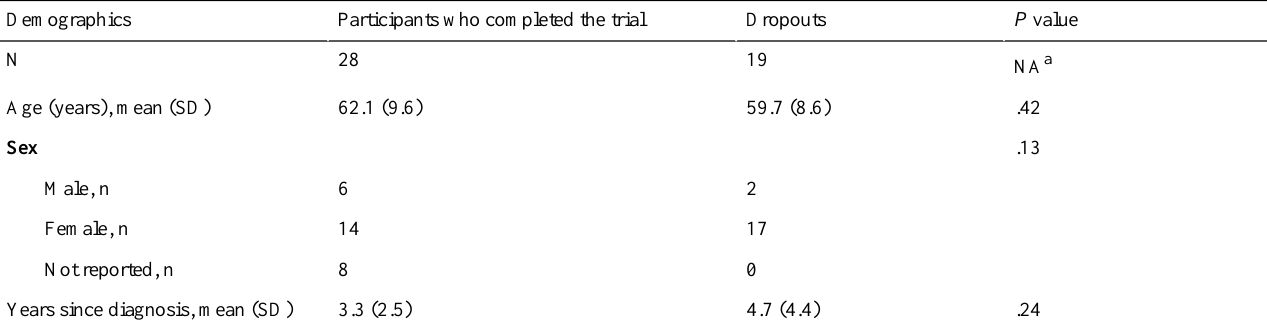
Table 1. Means, proportions, and statistical comparisons for participant demographics for those who completed the trial and dropouts.